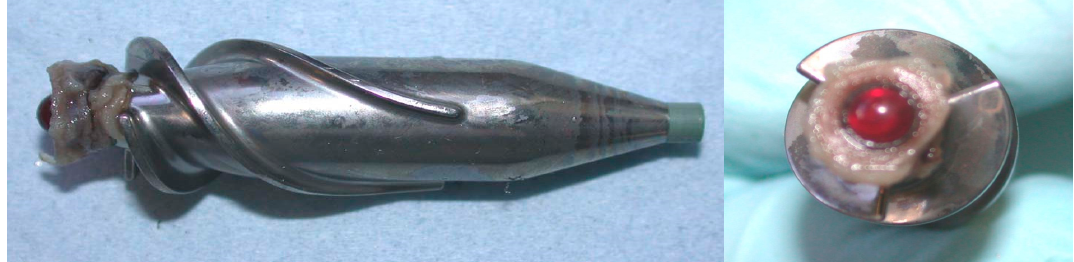
Figure 1. HeartMate II impeller: note thrombus formation around the ruby inlet bearing.